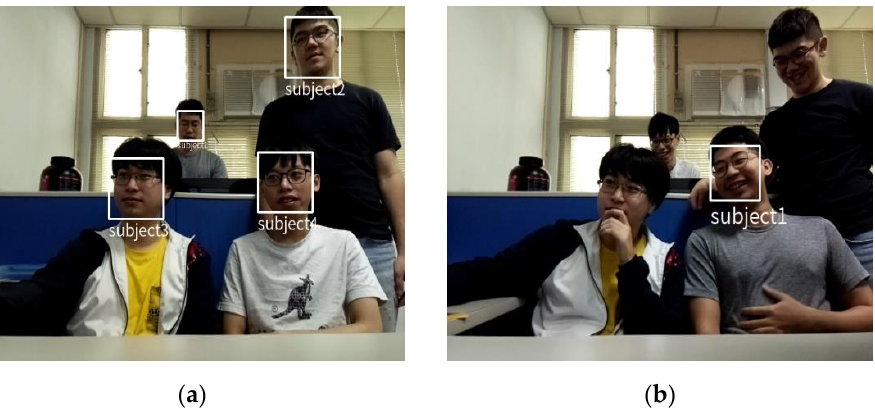
Figure 9. The performance of face detection using Dlib CNN ( a ) and Dlib HOG ( b ).